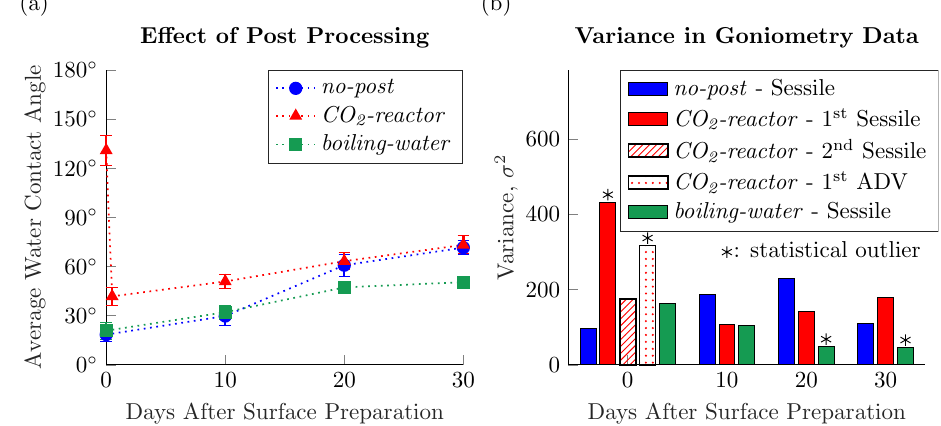
Figure 4. ( a ) Average sessile contact angle measured on the no-post , CO 2 -reactor , and boiling-water surfaces regardless of CO 2 jet volumetric flow rate during micromachining over the 30 days fol- lowing surface preparation. ( b ) Variance in the water contact angle data presented in part ( a ). Asterisk denotes a statistically-significant difference in variance compared to the rest of the dataset, as determined through